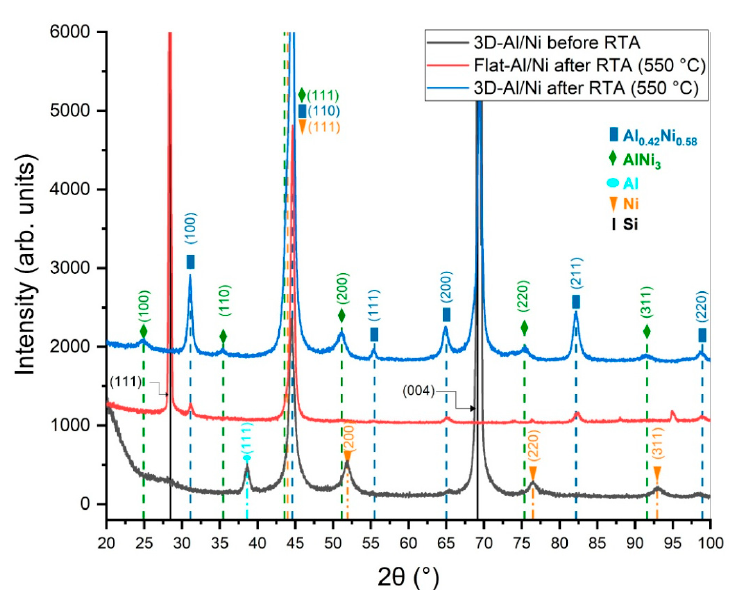
Figure 6. XRD diffraction patterns of 3D-RMS before and after RTA compared with standard RMS after RTA.